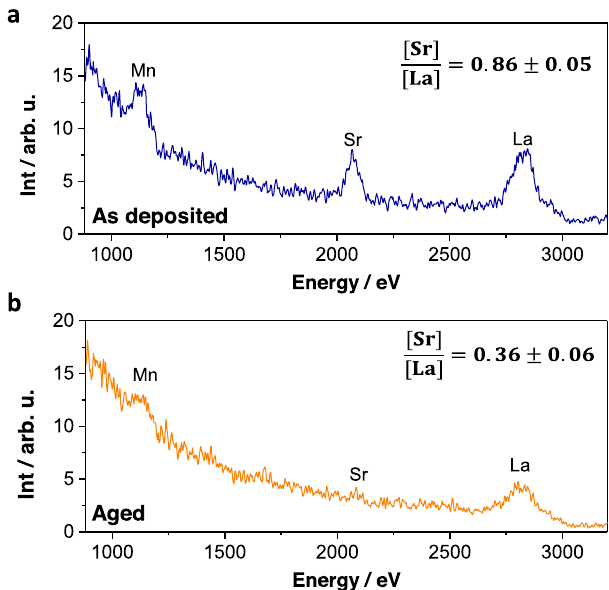
Fig. 5 LEIS spectra for LSM-SDC VAN. Analysis of surface as deposited ( a ) and after thermal treatment (100 h, 700 °C — b ). The stoichiometric ratio is obtained from integration of the peak areas. Absolute differences in peak intensities should be ascribed to the speci fi c experimental conditions.